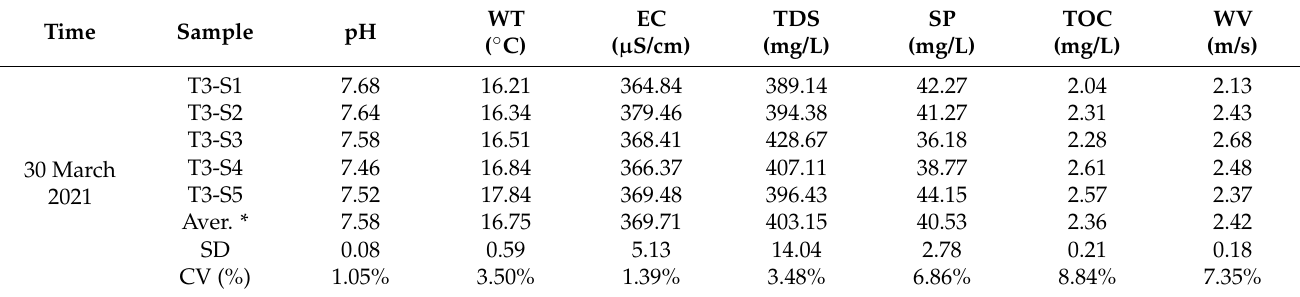
Figure 1. new fig 1. Figure 1. Distribution of groundwater sampling sites. Table 1. The physicochemical characteristics of the sampled